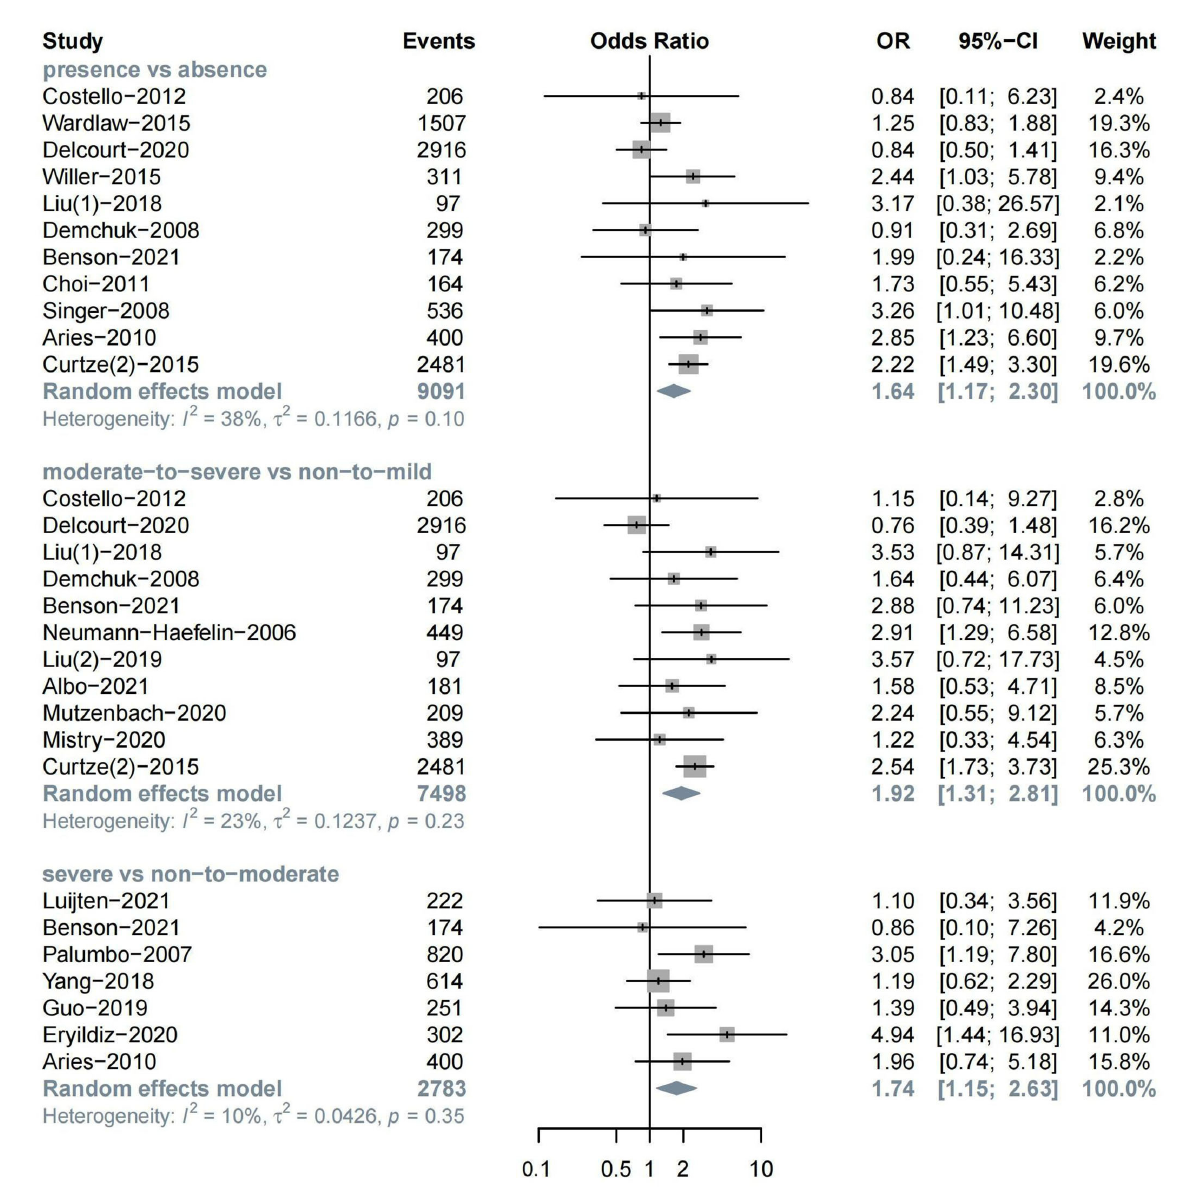
FIGURE3 The severity of WML and risk of symptomatic intracerebral hemorrhage (sICH).